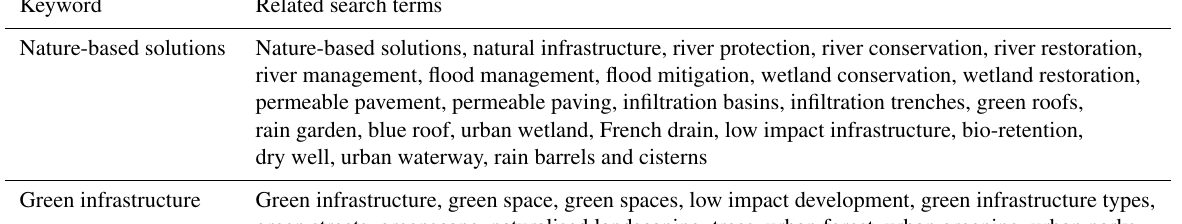
Table 2. Terms used in different combinations for the literature search. Keyword Related search terms